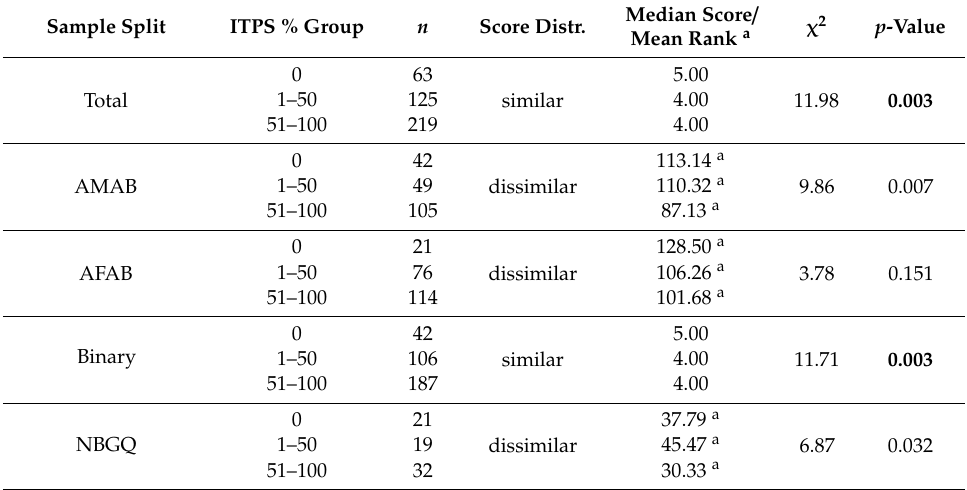
Table 3. Results of the Kruskal–Wallis H tests for the variable ‘desire for aftercare’. Sample